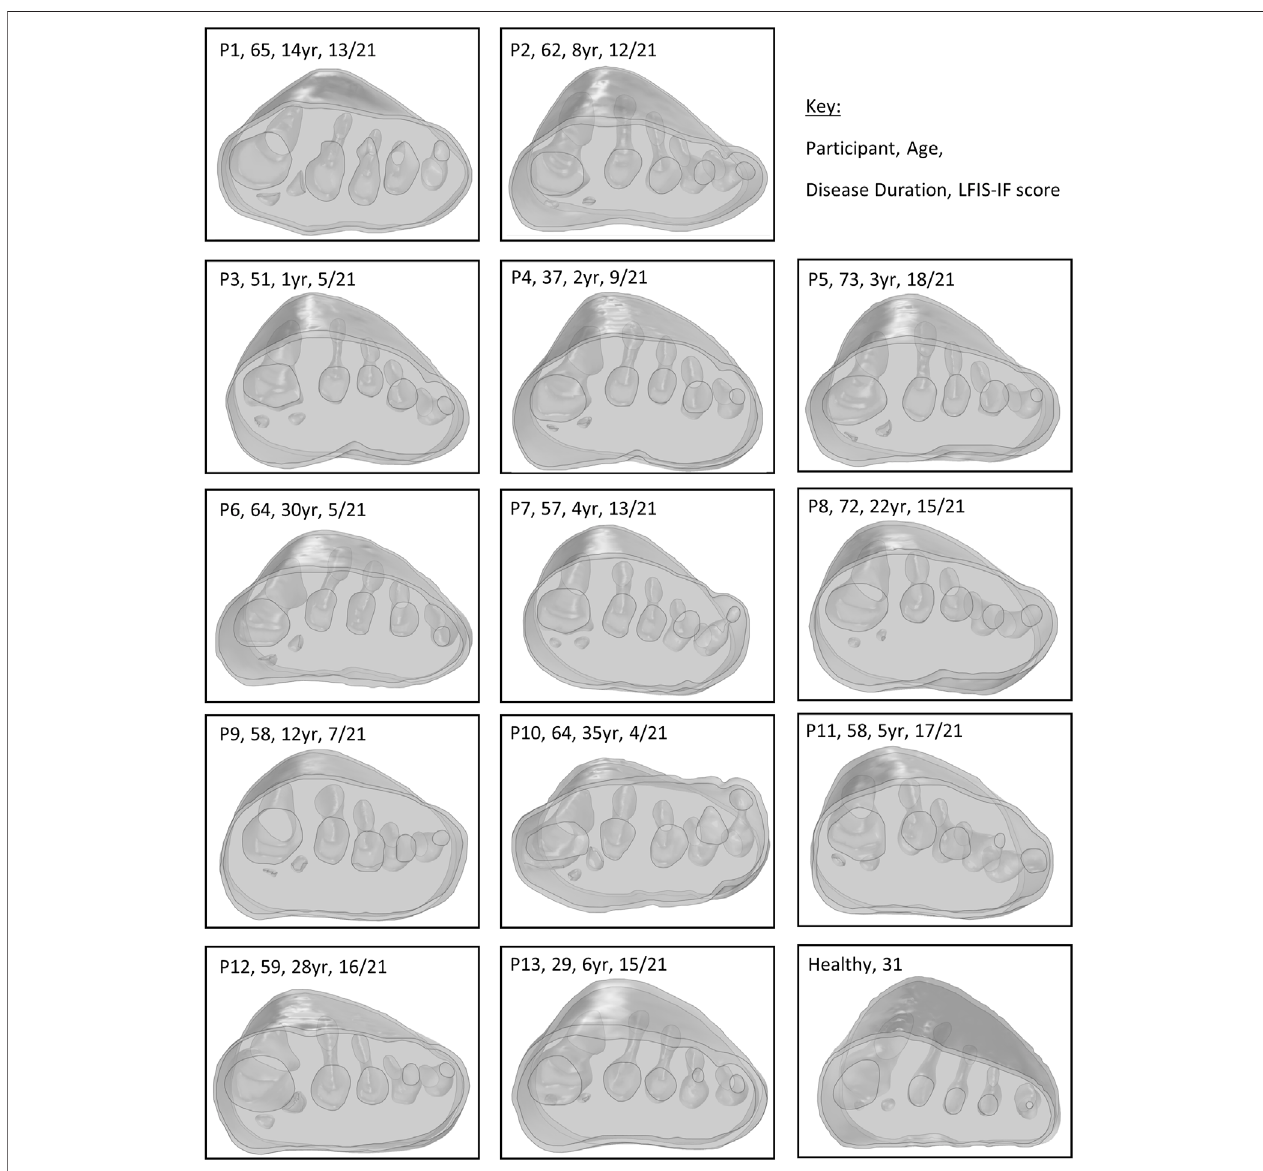
FIGURE3| Modelledforefeet(skin,encapsulatedbulksofttissue,bones)ofthe13participantswithRAandonehealthyparticipant,withageanddiseaseduration indicated.